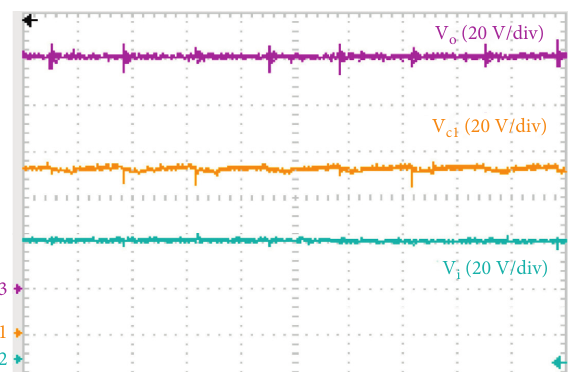
Figure 20: System voltages in steady-state boost operation of the converter: V